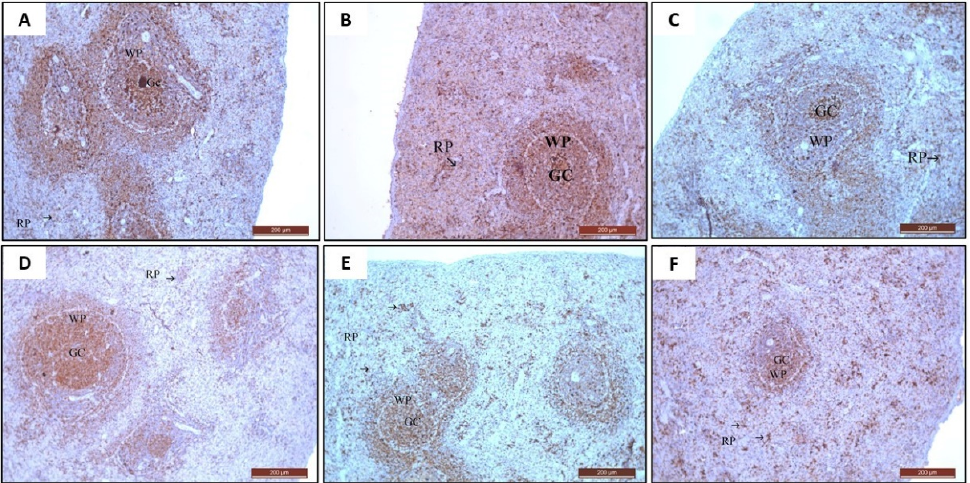
Figure 14. Photomicrographs of section of the spleen stained with anti-PCNA ×100 from different